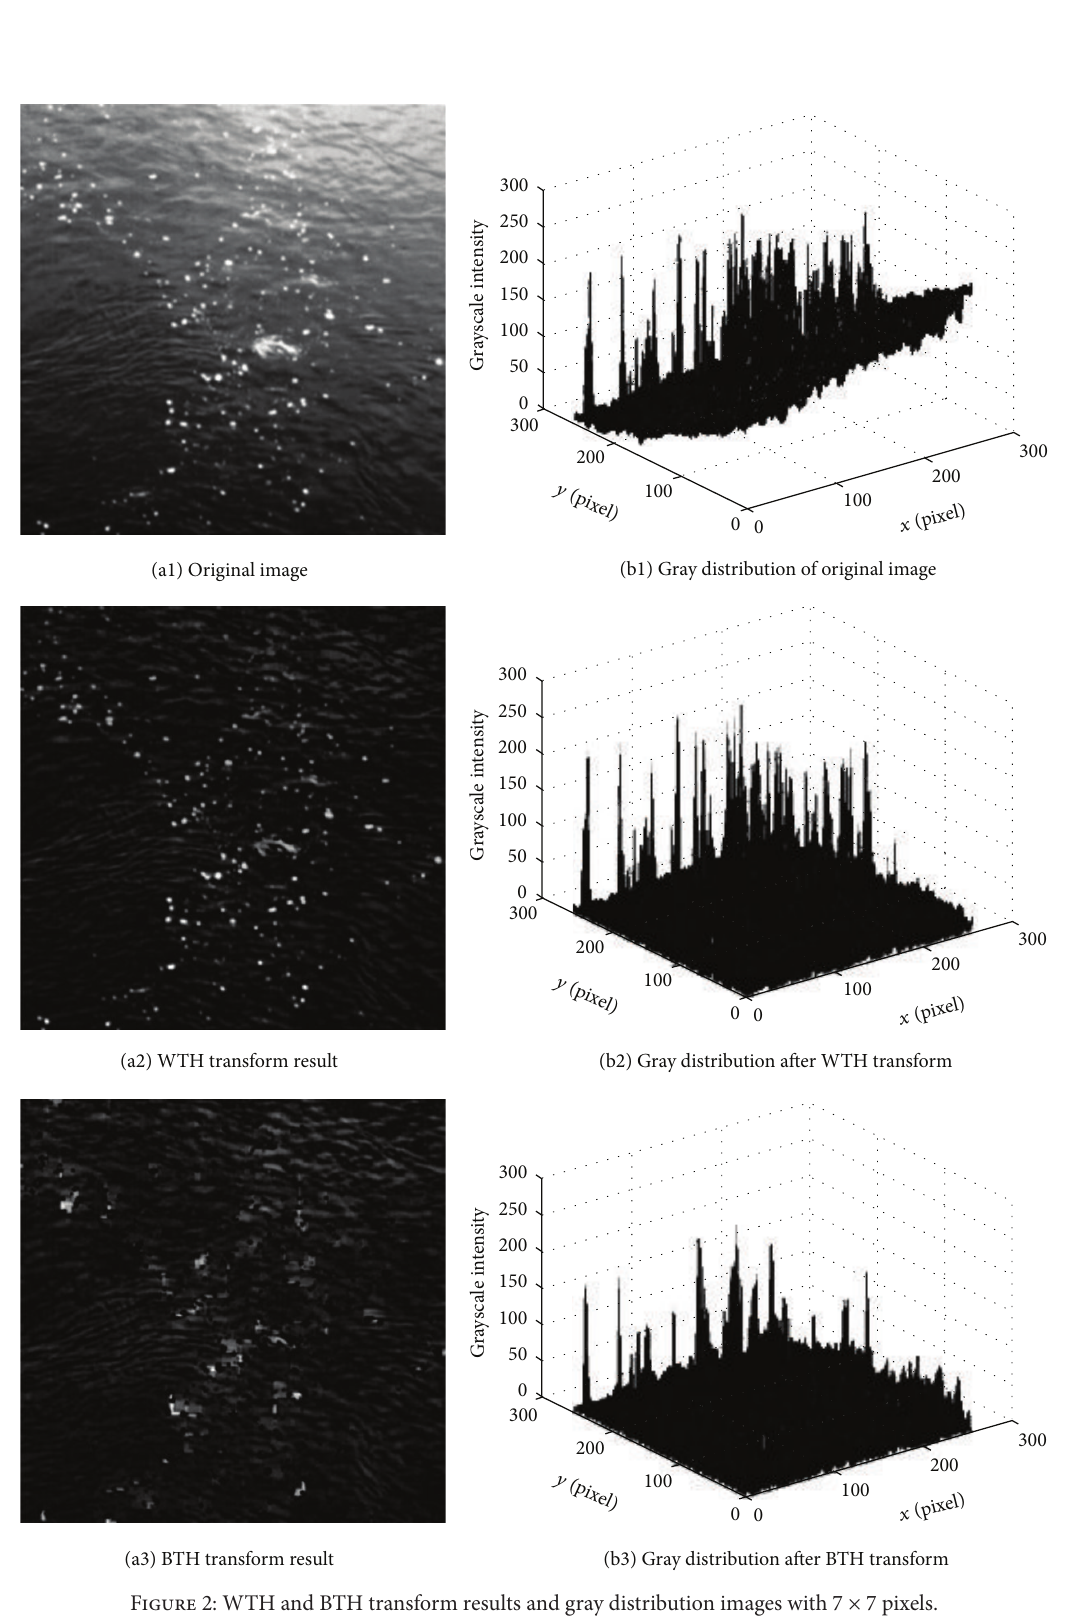
Figure 2: WTH and BTH transform results and gray distribution images with 7 × 7